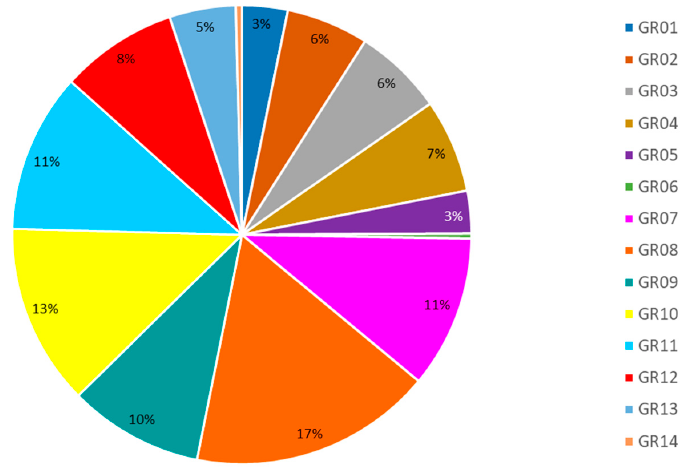
Figure 7. Distribution of exported virtual crop water on Greek RBDs, for base year 2011.